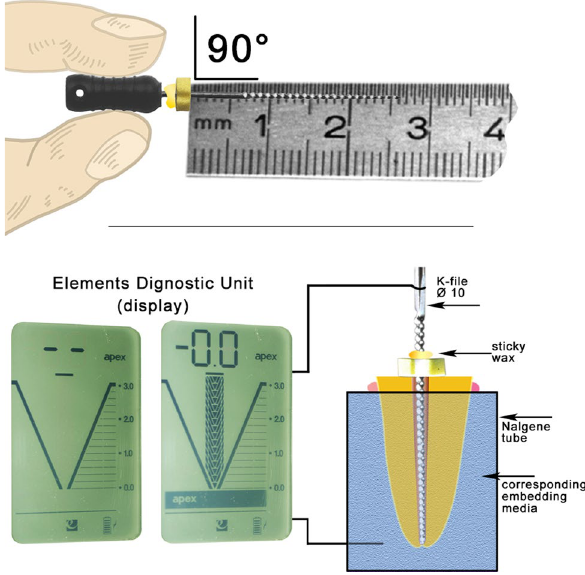
Figure 1. Diagrammatic visualization of the experimental setup of the electronic working length measurements (below) and precautions taken during the transmission of the corresponding measurements made (above). The Elements Diagnostic Unit apex locator measurement was determined to be correct as the display scale reached the “0.0” level, the “apex” sign below it appeared and a corresponding acoustic signal was